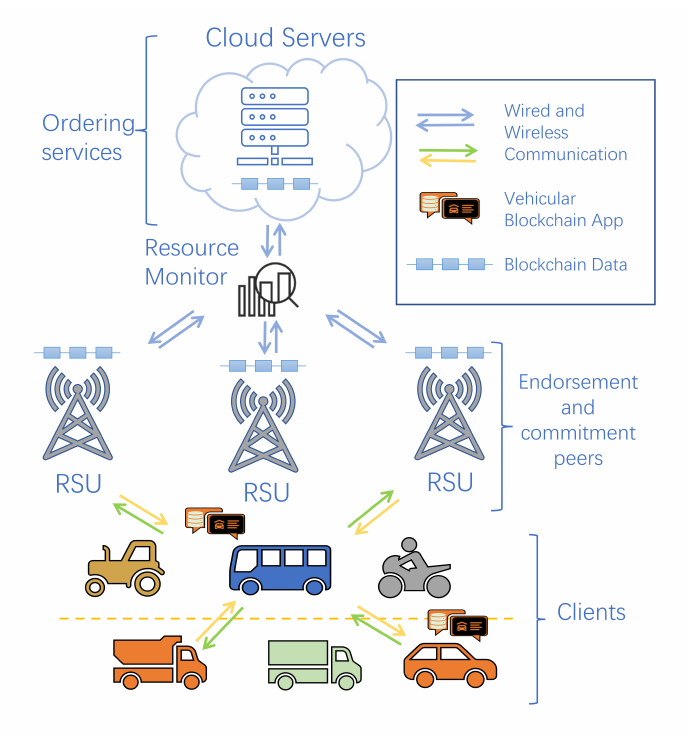
Figure 1. System architecture.